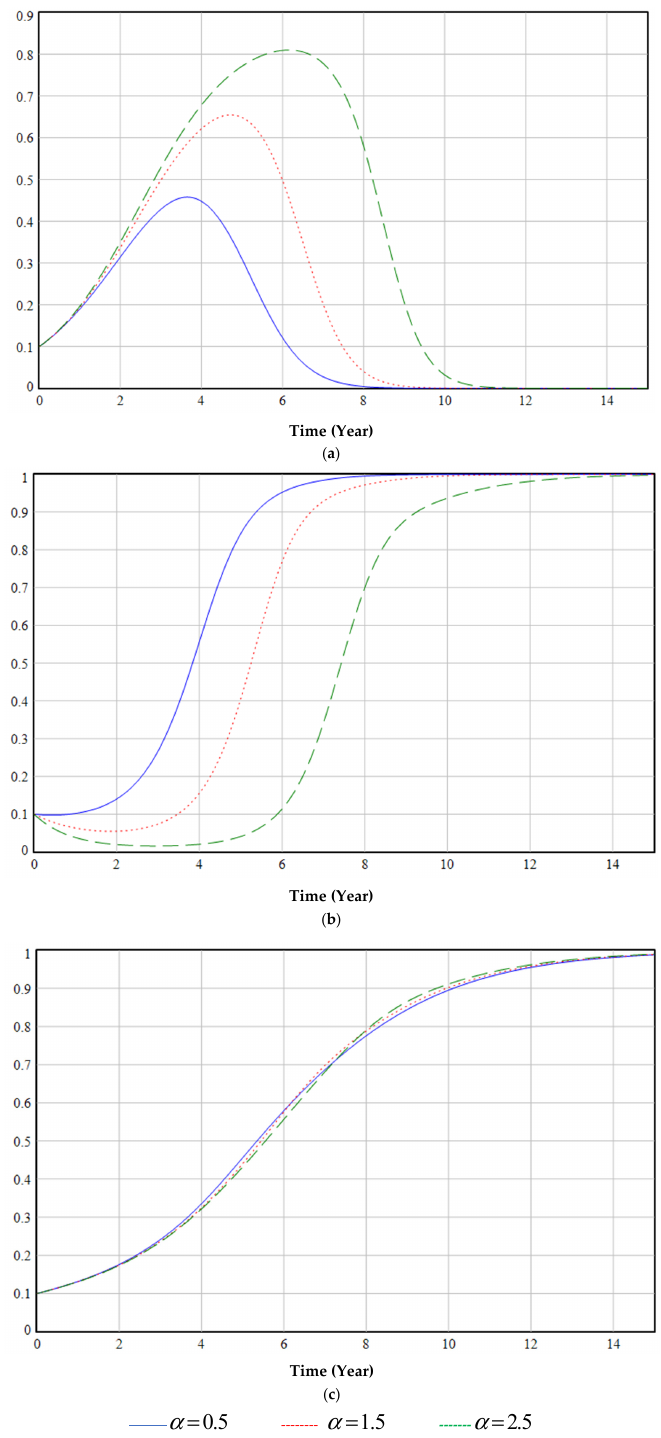
Figure 12. The effect of β on decisions of government ( a ), enterprises ( b ), and medical institutions ( c ).